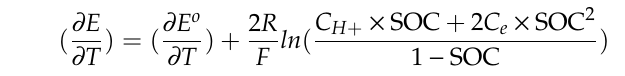
Table 2. Thermodynamic data for vanadium and iodine compounds at 298.15 K.